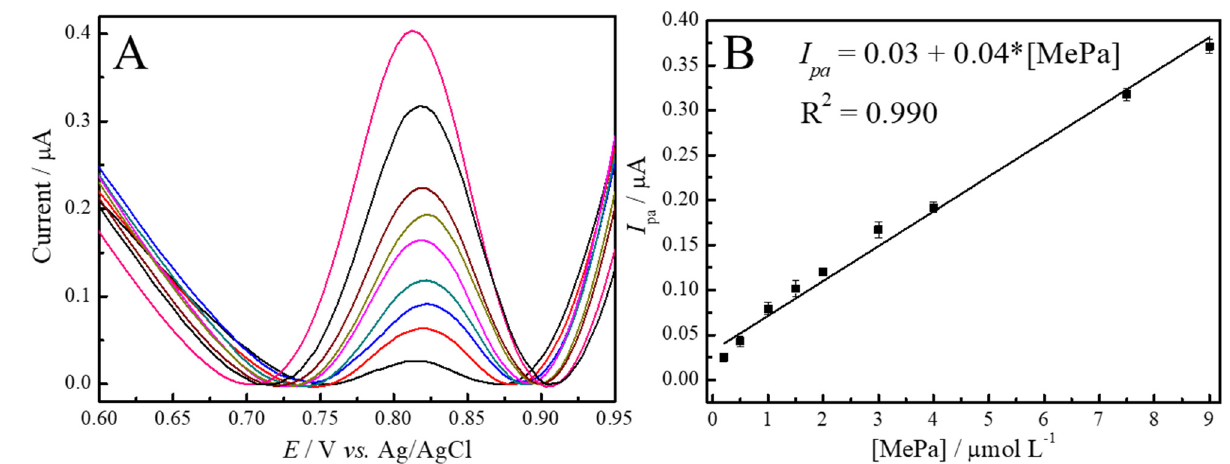
Figure 4. ( A ) Differential pulse voltammograms using GC/RC-SbNPs in 0.1 mol L − 1 PBS pH 7.0 solution at different concentrations of MePa. ( B ) Linear relation between peak anodic currents and the MePa concentrations.